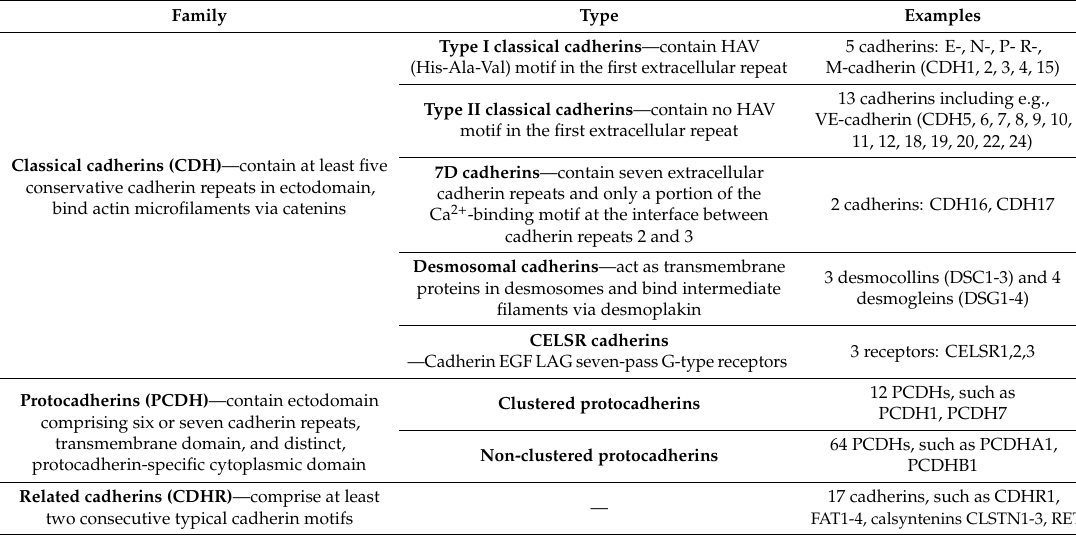
(I) 30 classical cadherins, (II) 76 protocadherins, and (III) 17 cadherin-related proteins (Table 1). Table 1. Classification of cadherin superfamily according to [8].